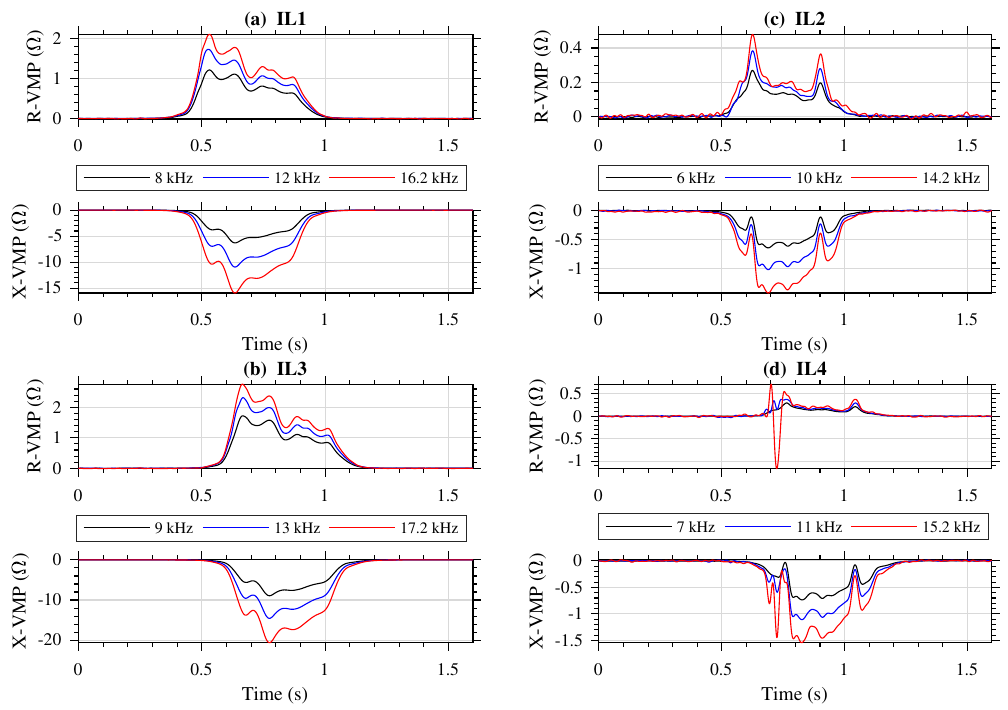
Figure 9. VMPs of a delivery car shown in Figure 7b, further description the same as in Figure 8.